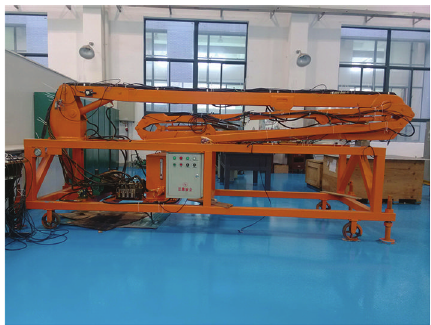
Figure 11: The multibody boom test rig.